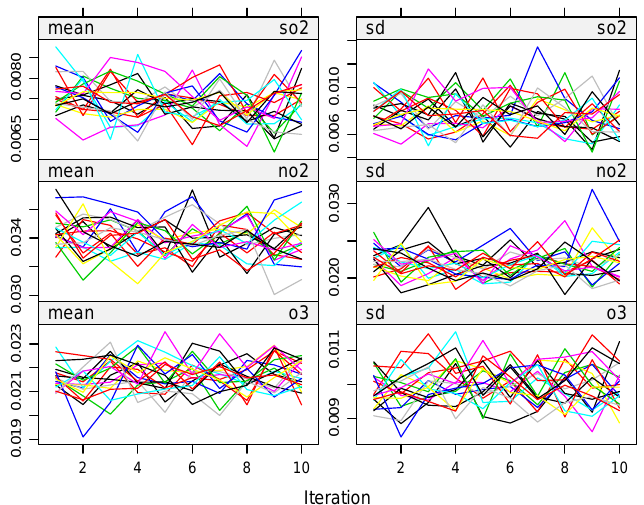
Figure A7. Inspecting the trace line convergence levels using an iterative Markov Chain–Monte Carlo type of algorithm with respect to the imputed means and standard deviations for SO 2 , NO 2 , and O 3 . These trace plots show the imputed value summaries for all imputed data sets with m = 20 after applying 10 iterations, in order to reach to the convergence level of stability. Each color in the graph represents an imputed data set, where the x-axis represents the number of iterations implemented during the imputational calculation and the y-axis represents the mean ( left -side) and standard deviation ( right -side) of the imputed values